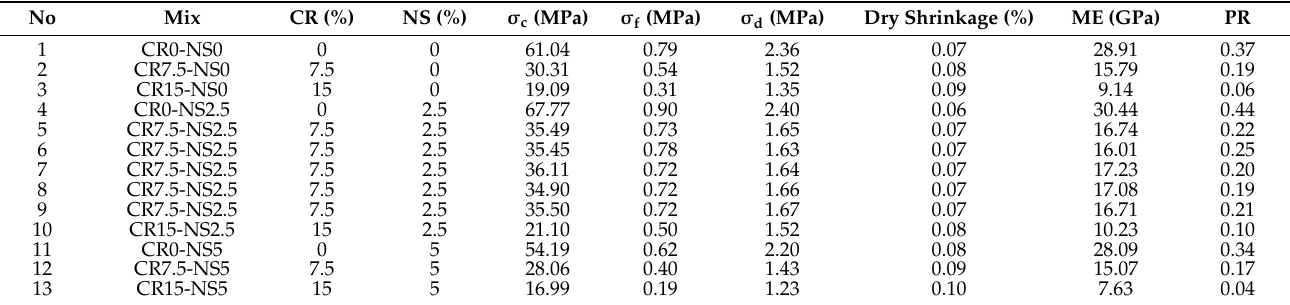
Table 7. Experimental design matrix and responses for NS-CRM.